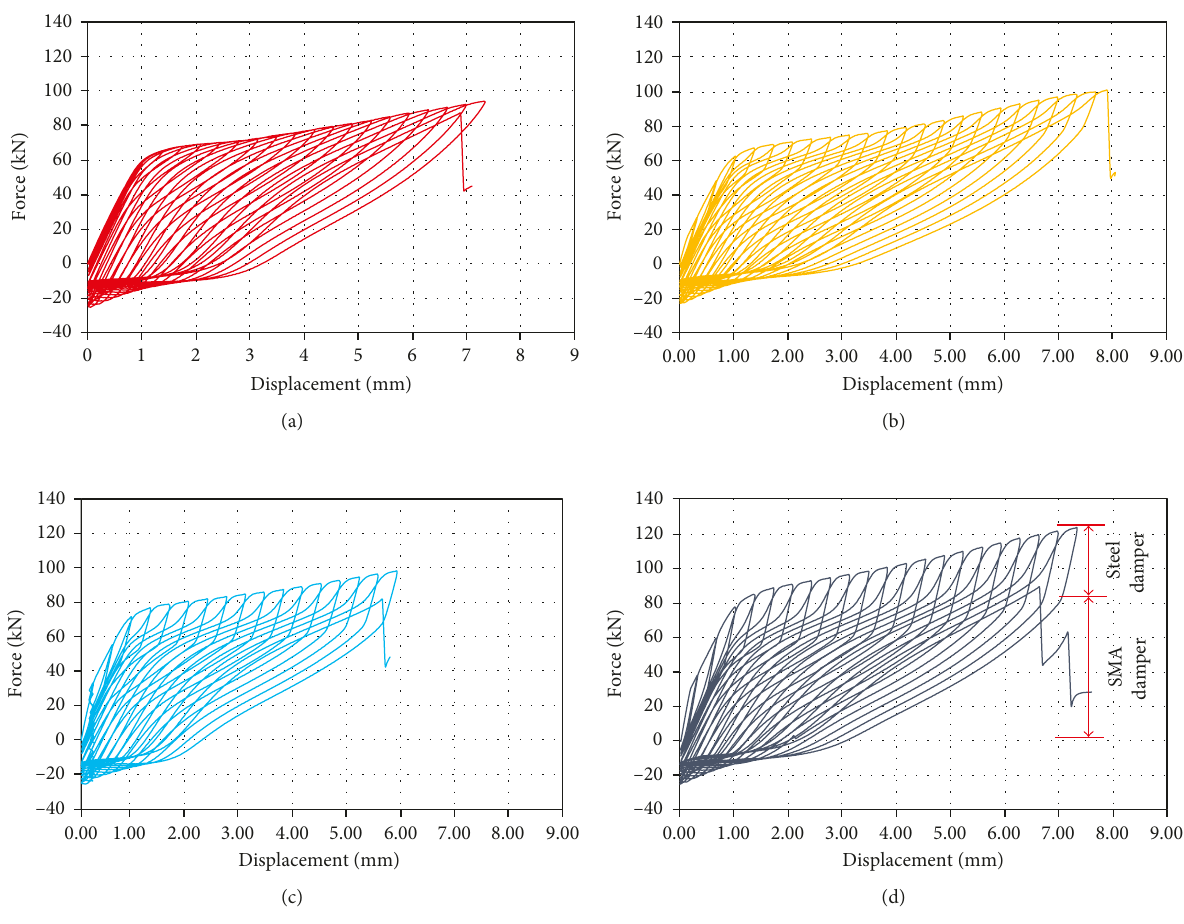
Figure 10: Force and displacement curves. (a) SMA-BR-1. (b) SMA-BR-2. (c) SMA-BR-3. (d)